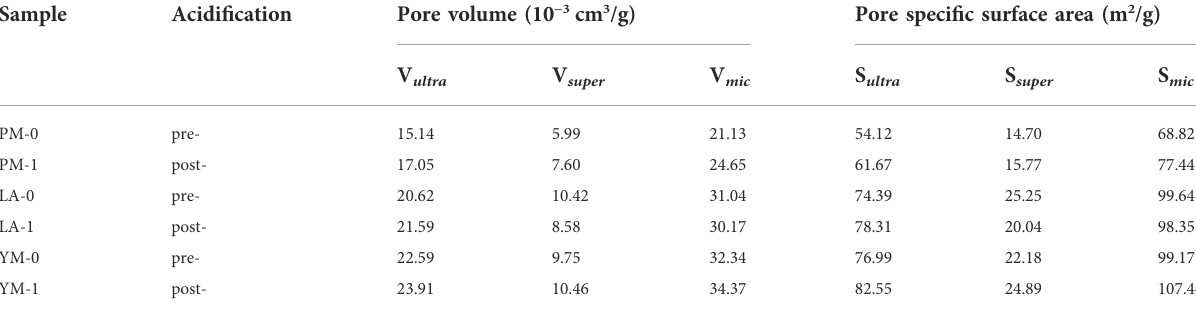
TABLE 1 Micropore structural parameters of the raw and acidi fi ed coal samples from the LPGA-CO 2 measurement a .